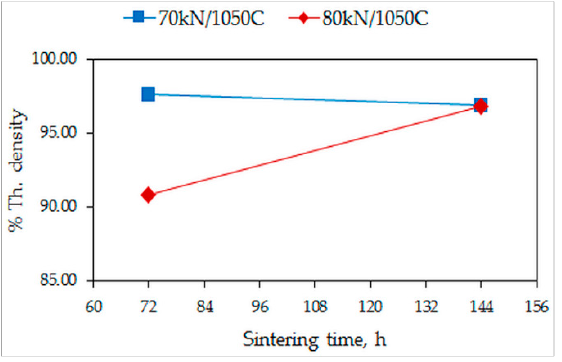
Figure 3. Variation of % theoretical density with sintering time of quaternary alloys S1050a3, S1050a4, S1050b3, and S1050b4.